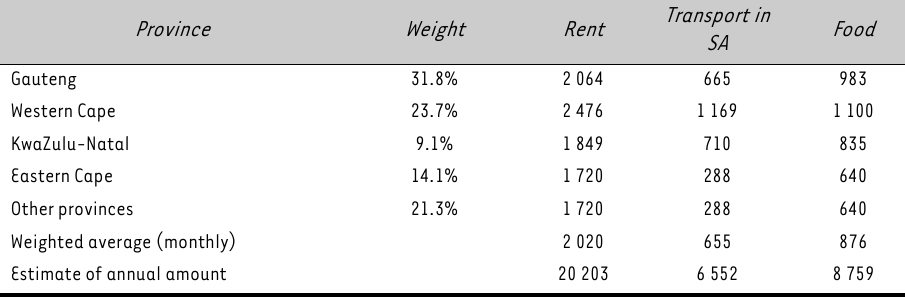
Table 6: Mean monthly spending per category by province Province Weight Rent